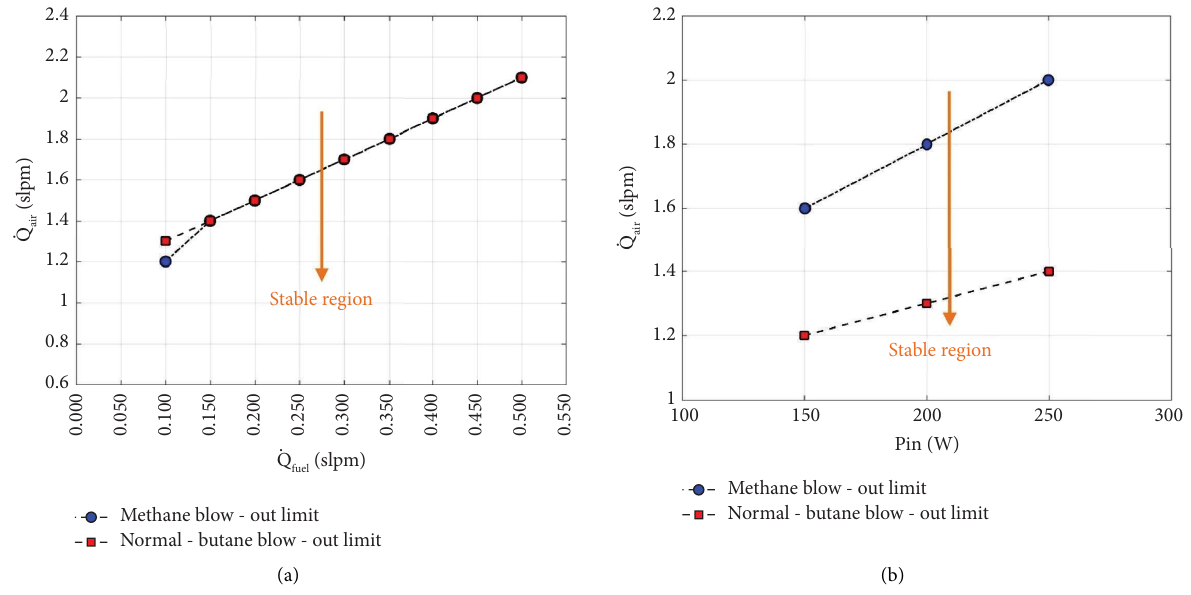
Figure 4: (a) Stability limits for methane and n-butane; (b) comparison of stability limits of methane and n-butane at the same input powers.